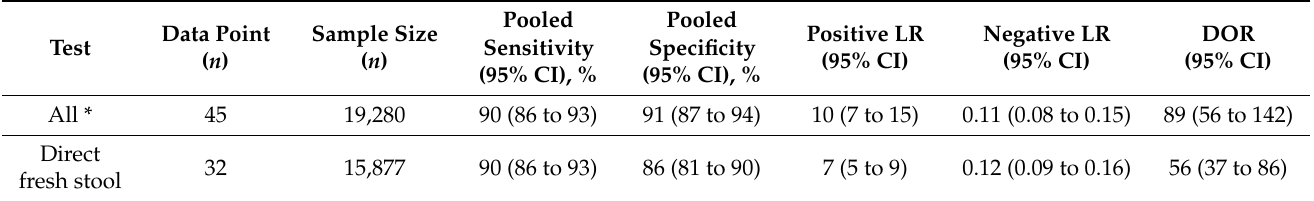
Table 2. Results of pooled sensitivity and specificity of cholera RDTs using direct fresh stool for V. cholerae O1 detection. Test